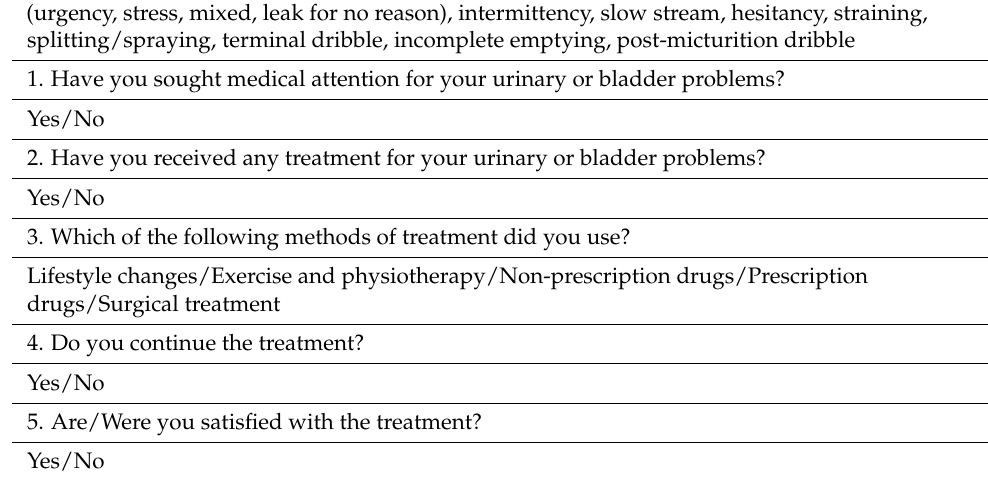
Table 1. Questions regarding treatment seeking, treatment receiving, treatment methods used, treatment satisfaction, and treatment